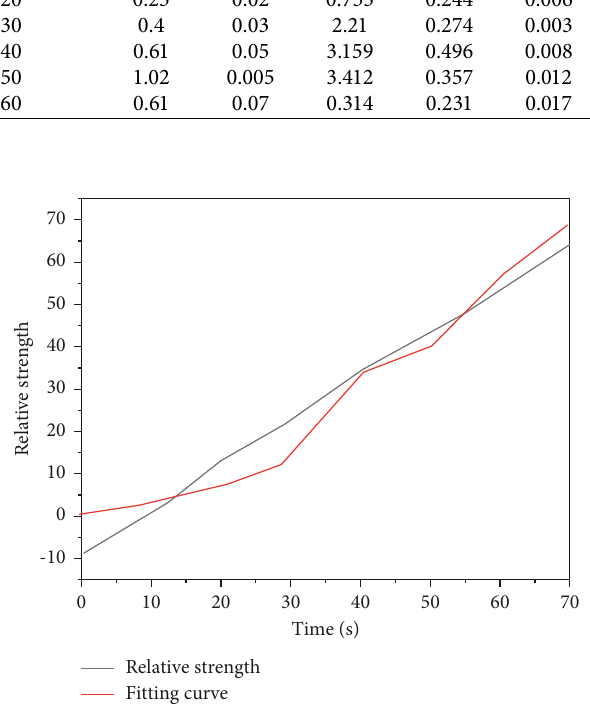
Figure 6: Curve and fitting curve of load-muscle